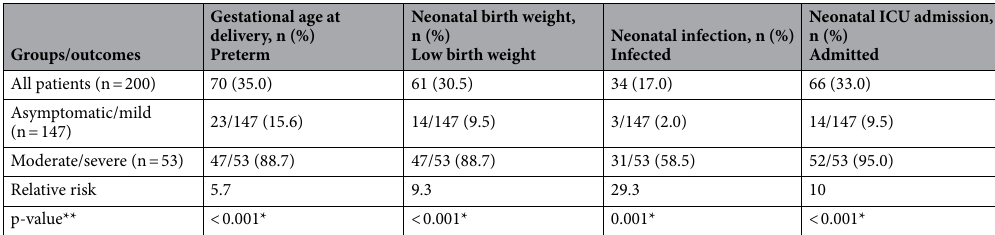
Table 2. Neonatal outcomes. *Significance at p-value < 0.05. **Fisher Exact Test ( X 2 ).